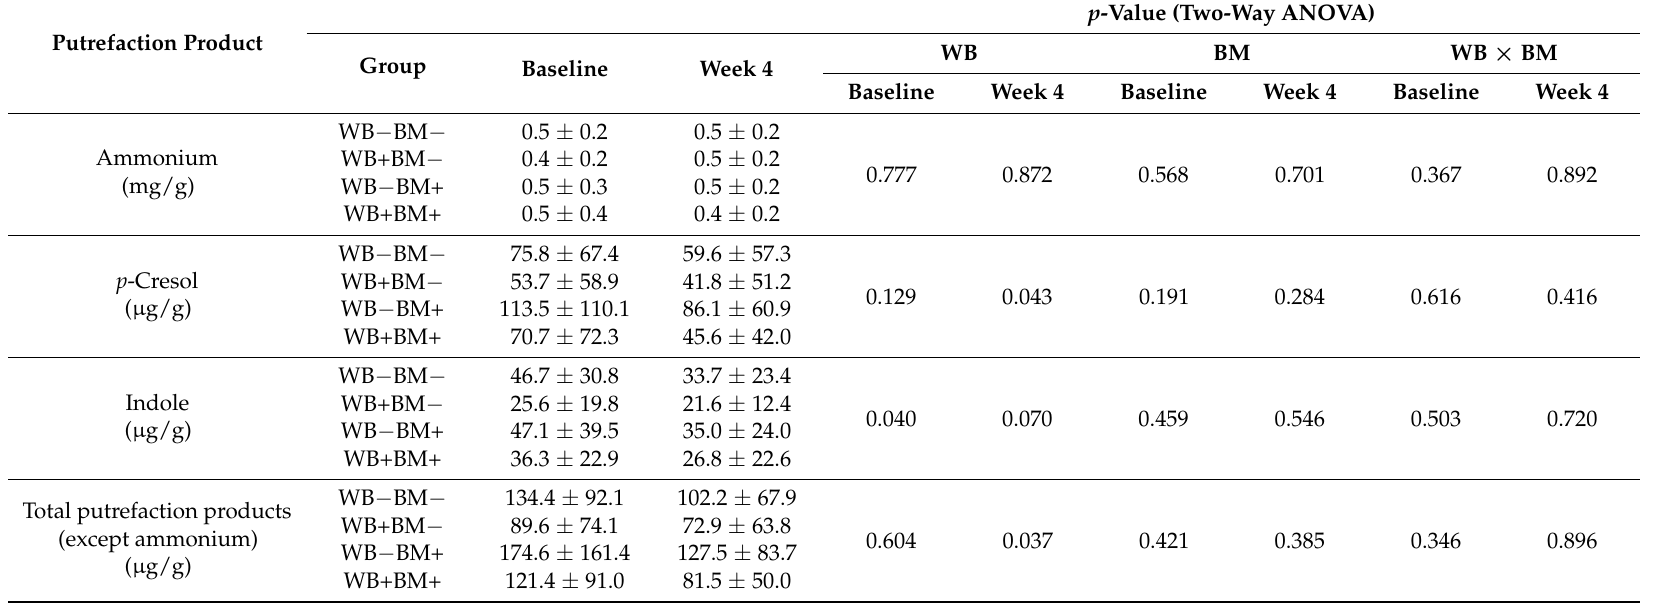
Table 9. Concentrations of fecal putrefaction products in stool samples obtained at baseline and week 4.